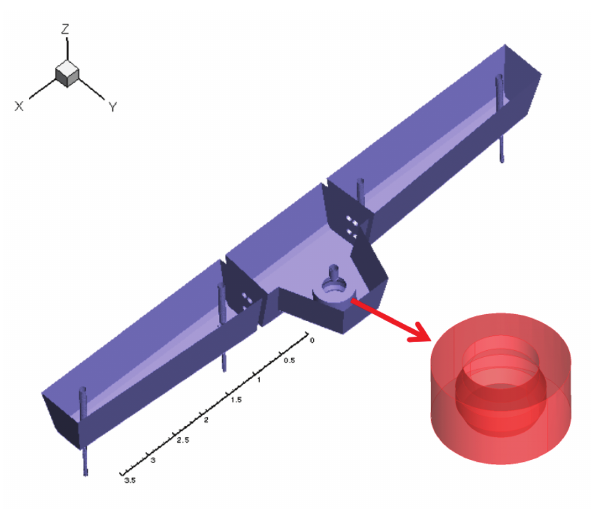
Figure 1: The tundish with a conventional turbulence inhibitor.